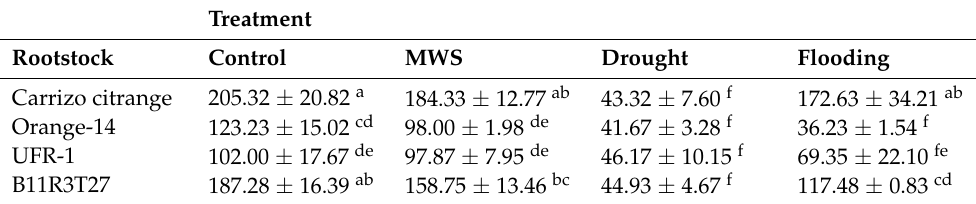
Table 3. Mean stomatal conductance values (mmol m − 2 s − 1 ) on four citrus rootstocks (Carrizo citrange, Orange-14, UFR-1, and B11R3T27) under four water conditions treatments (Control, MWS, Drought, and Flooding) at the end of the